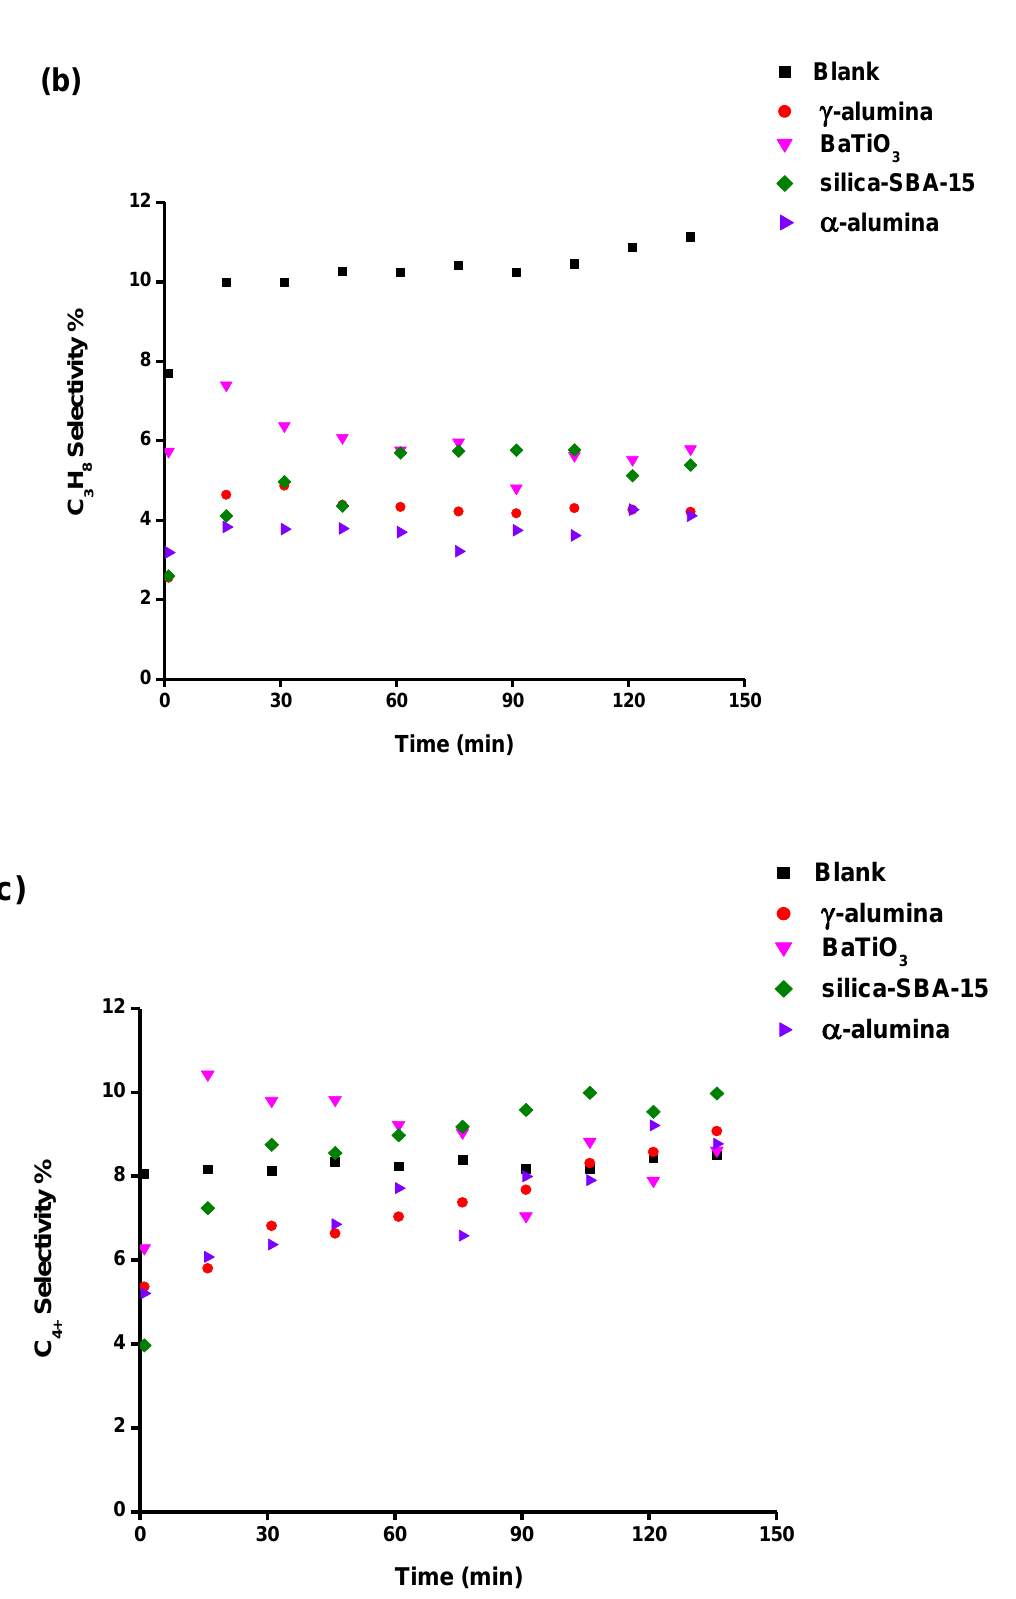
Figure 8. The selectivity of C 3 and other hydrocarbon (C 4+ ) products as a function of time for different packing materials: ( a ) C 3 H 6 selectivity; ( b ) C 3 H 8 selectivity; and ( c ) other hydrocarbons selectivity.